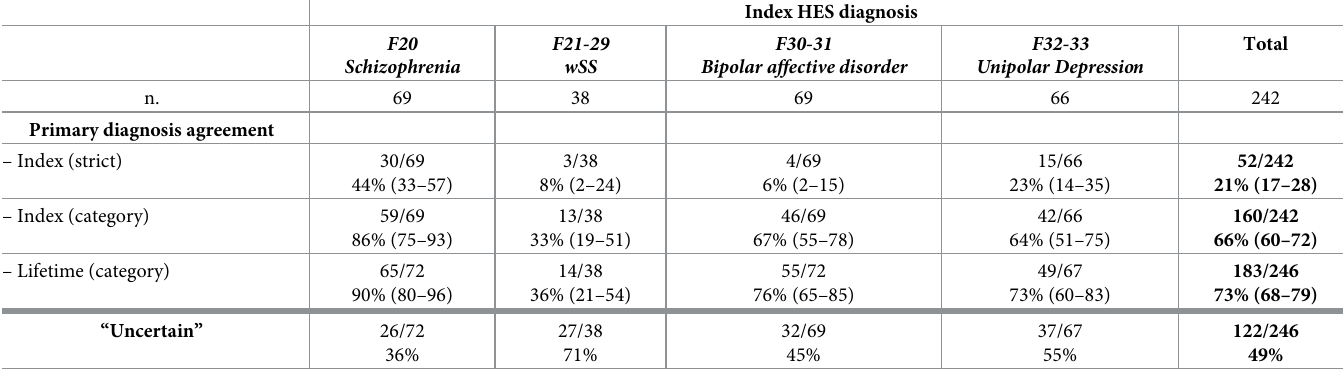
Table 2. Agreement rates for index HES diagnosis and research primary diagnosis (index and lifetime) by index HES diagnosis. Index (strict) refers to exact diagno- sisprecipitating admission (3 figure ICD-10 code), Index (category) refers to diagnostic group precipitating admission, Lifetime (category) refers to diagnostic group life- time occurrence. “Uncertain” refers to the research assessor marking the lifetime diagnosis as being